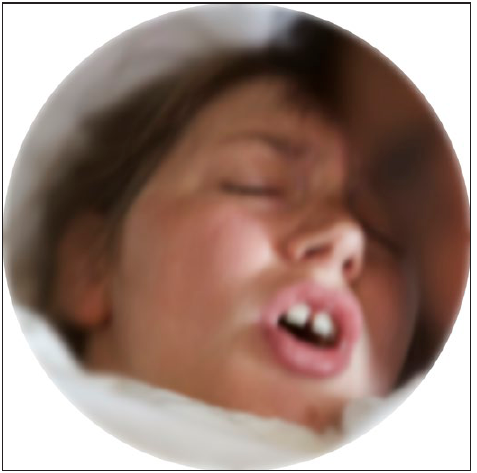
Figure 5: Deirdre Donoghue, Lilly (2015) / Note from the artists: this image represents my doula practice and is a picture of a woman in transition. It is used with permission.